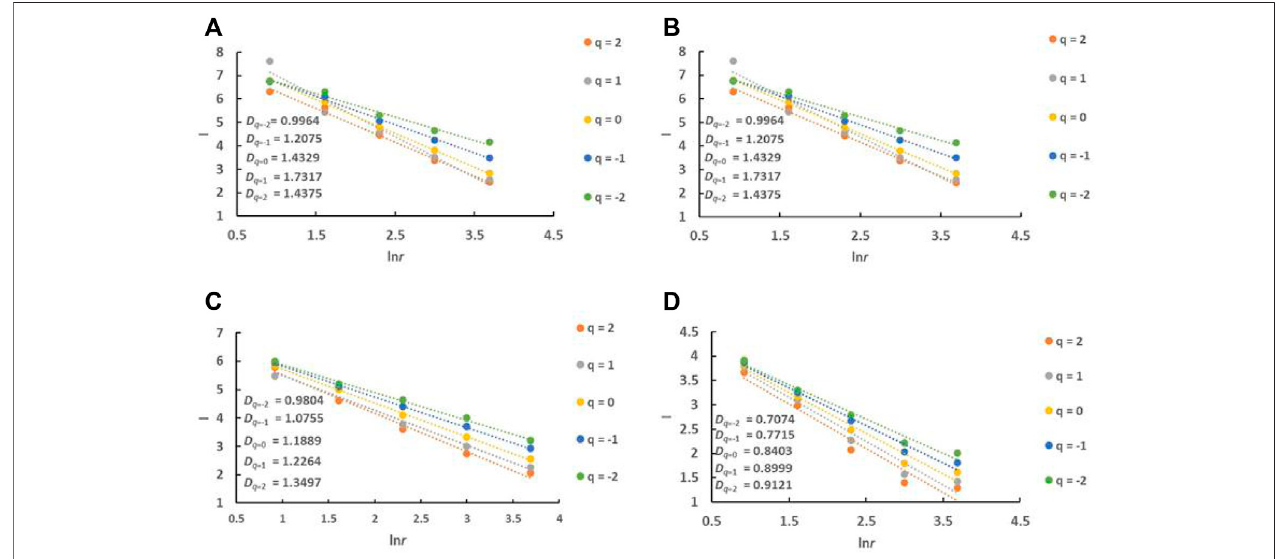
FIGURE4| ln( r )- I q ( r )curvesoffaultdistribution inMaokouFormationinsoutheastSichuan (A) allfaultsinstudyarea; (B) NW-trendingfaults; (C) NE-trendingfaults; (D) EW-trending faults.